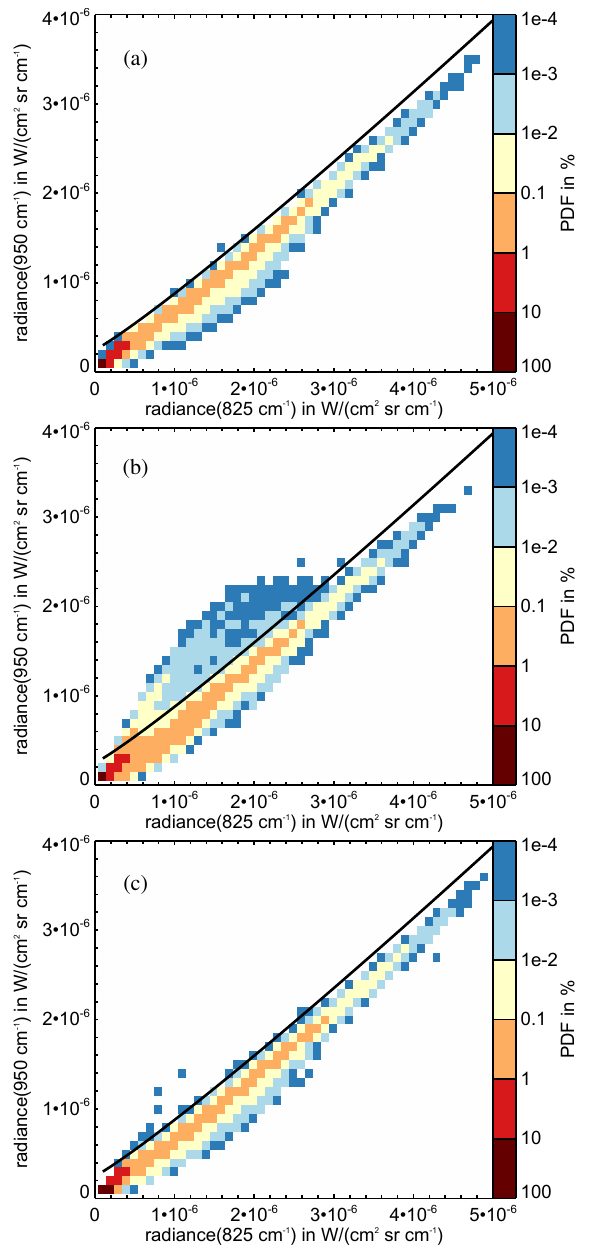
Figure 6. Frequency density of MIPAS radiances in the South- Fig. 6. Frequency density of MIPAS radiances in the southern hemi- ern Hemisphere below 30km altitude. (a) Pre-eruption phase from sphere below 30km altitude. (a) Pre-eruption phase from January to January to May 2011. (b) Post-eruption phase from June to Au- May 2011. (b) Post-eruption phase from June to August 2011. The gust 2011. The eruption of the Puyehue-Cordón Caulle started on eruption of the Puyehue-Cord´on Caulle started on 4 June 2011. (c) 4 June 2011. (c) Post-eruption phase from September to Decem- Post-eruption phase from September to December 2011. The black ber 2011. The black line is the ash detection threshold function. line is the ash detection threshold function.